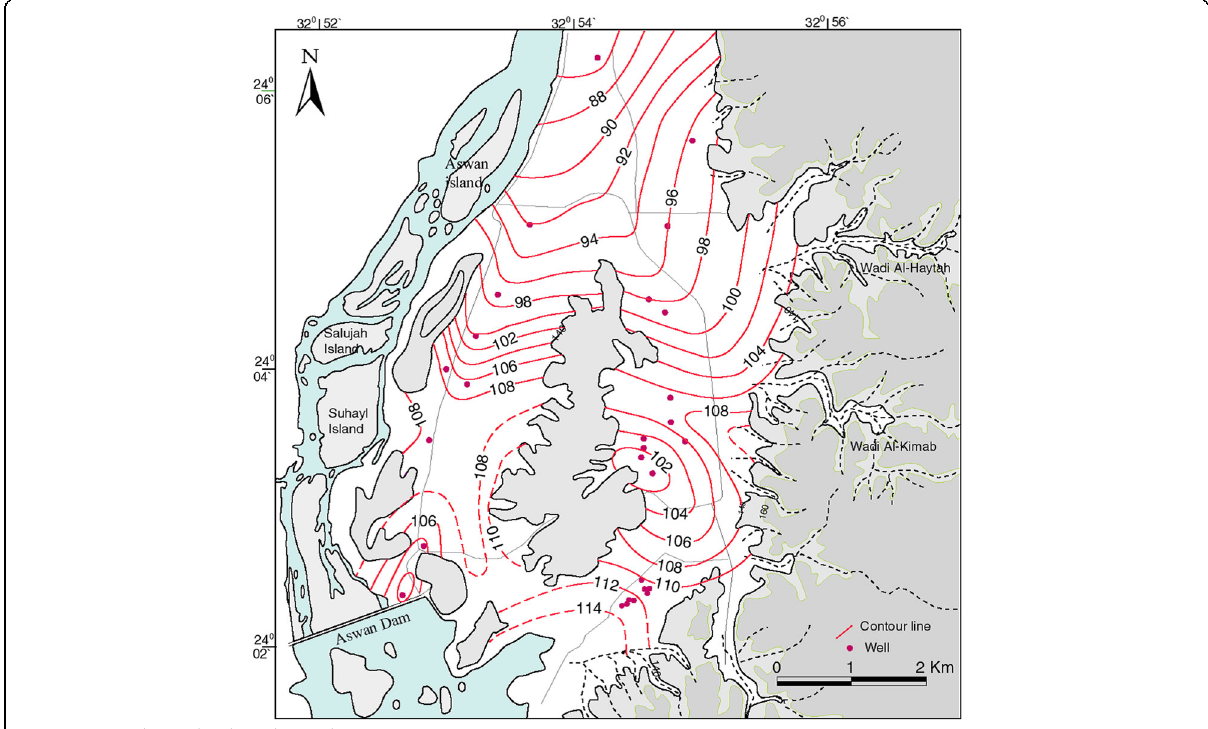
Fig. 15 Groundwater levels in the study area